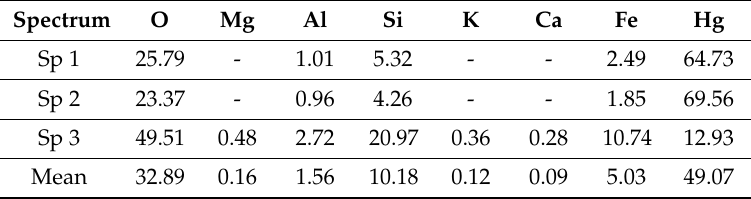
Table 5. Mass percentage values of the detected elements on the three marked points (Spectra, Sp) for